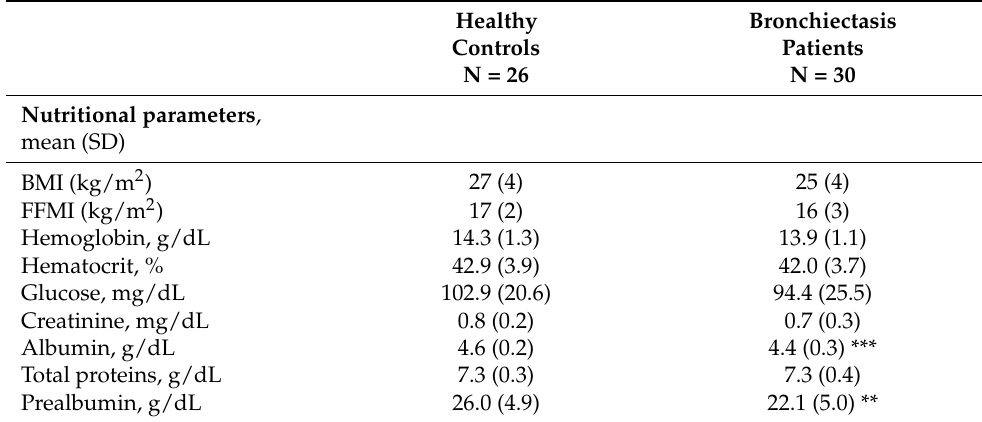
Table 2. Nutritional assessment in bronchiectasis patients and healthy controls.